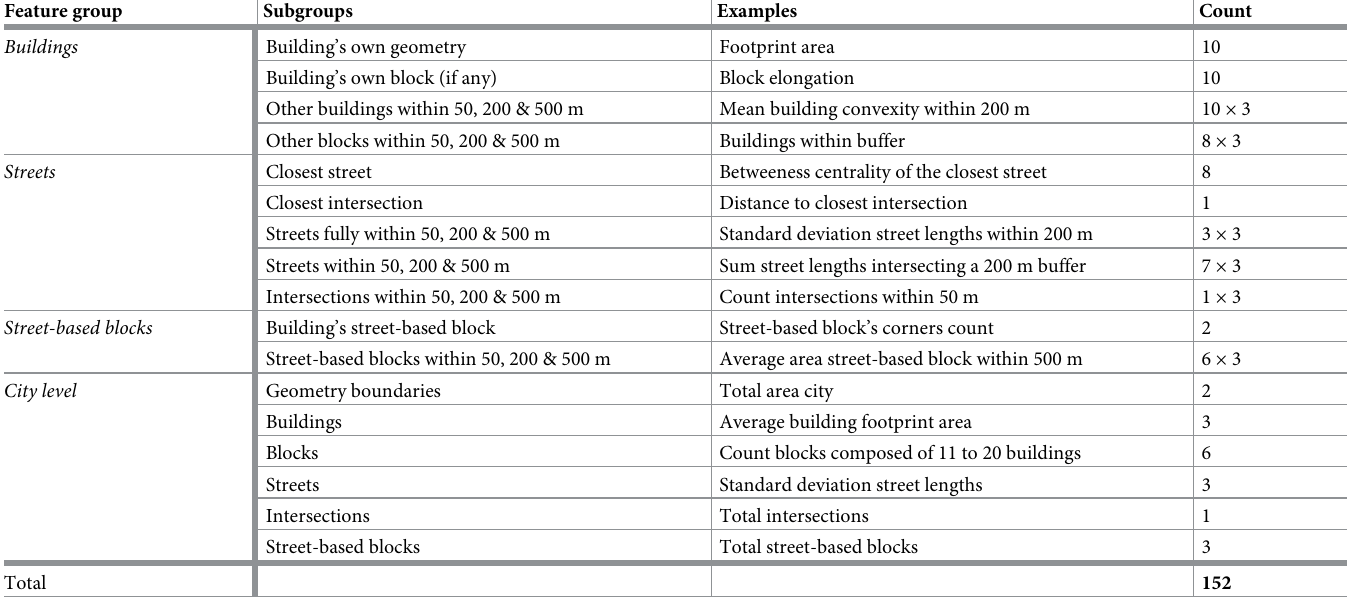
Table 2. Summary of urban form features used in this